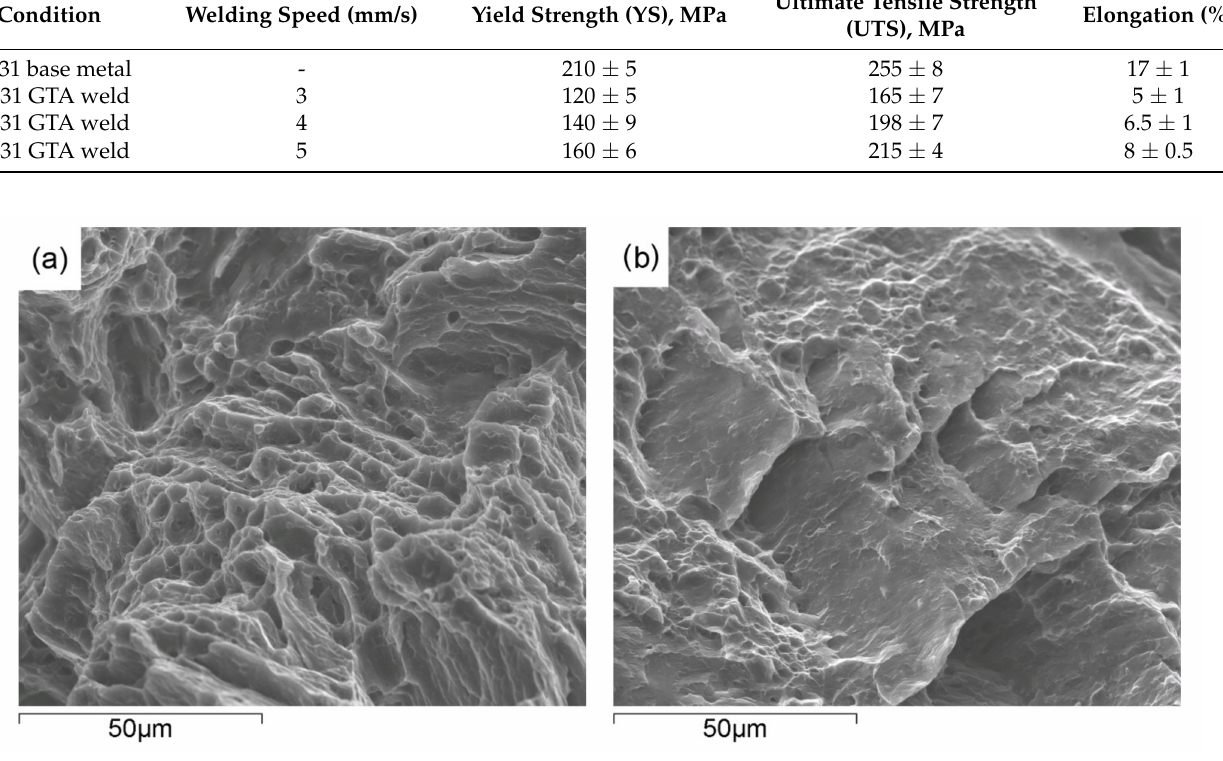
Figure 12. The tensile fracture surfaces of the welded joints fabricated with high and low welding speeds. ( a ) 5 mm/s. ( b ) 3